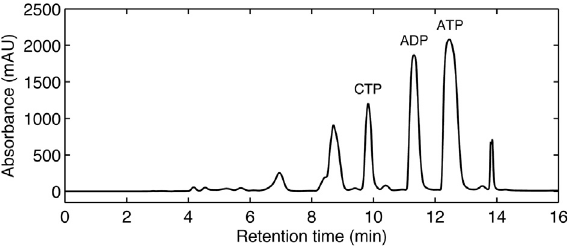
Figure 13. Chromatogram of semi-preparative scale puri fi cation of [4 ′ - 2 H]CTP by ion-pair reversed-phase HPLC.